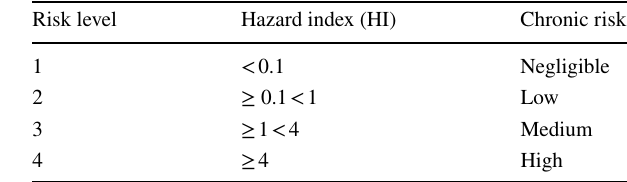
Table 1 USEPA (1989) classification of non-carcinogenic risk Risk